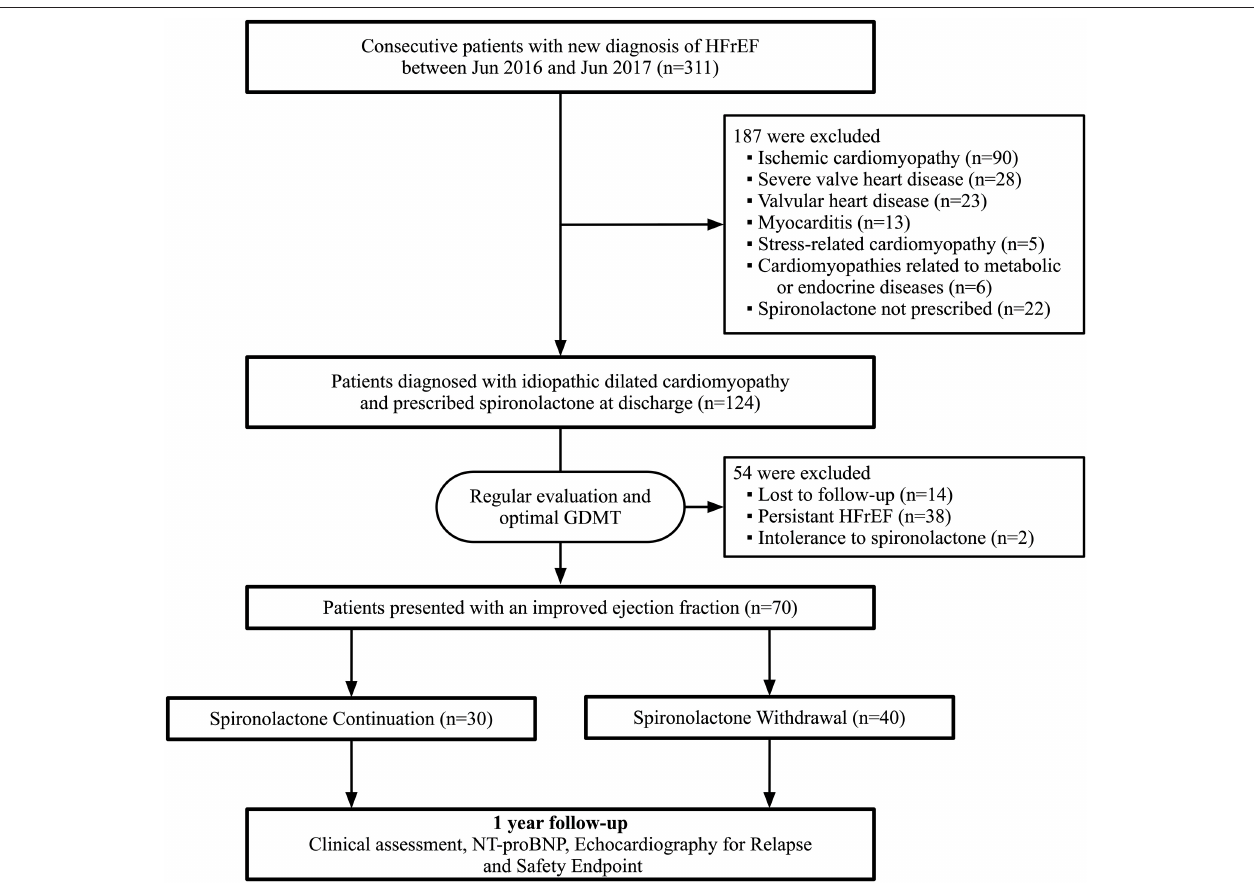
FIGURE 1 | Flowchart of study profile. HFrEF, heart failure with reduced ejection fraction; GDMT, guideline-directed medical therapy; NT-proBNP, N-terminal pro-B-type natriuretic